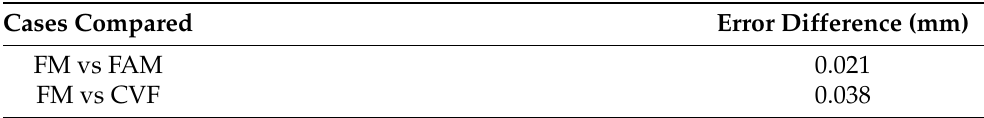
Table 3. RMSE error differences among cases: FM vs. FAM, and FM vs.